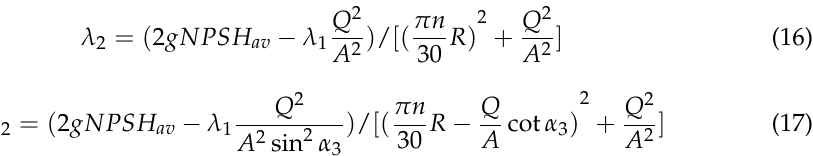
Table 2. Calculation results of λ 2 and λ 2 (cid:48) with minimum NPSH c for 5 blade angles.